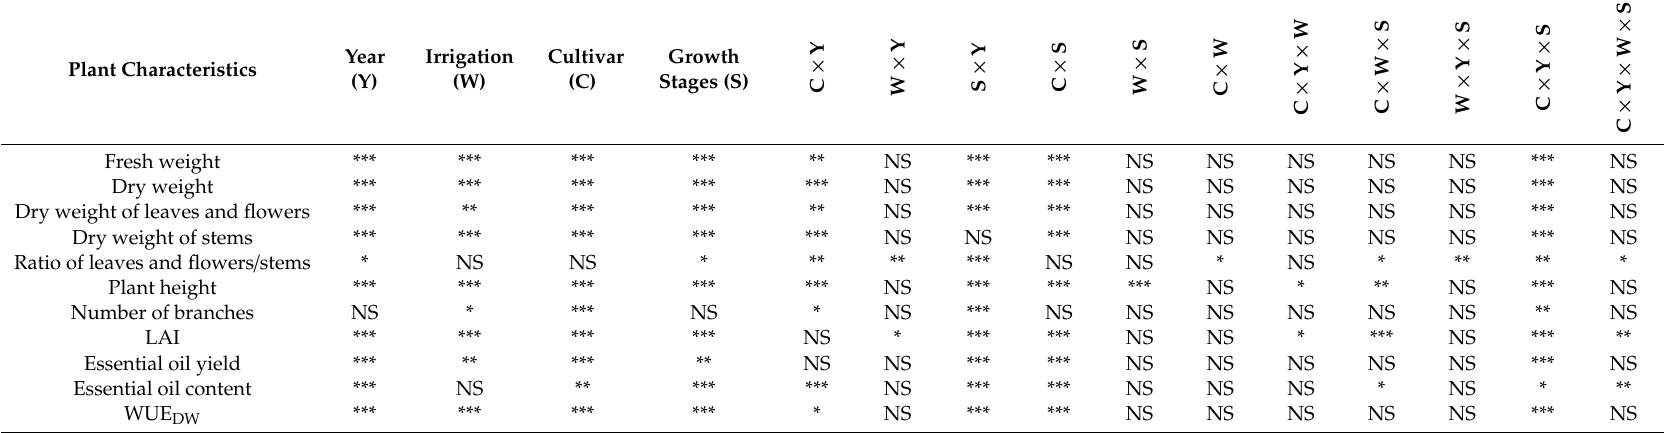
Table 3. Analysis of variance results (significance of the e ff ects) for testing the e ff ects (main and interactions) of Year (Y), Irrigation (W), Cultivar (C), and Growth Stages (S) on the measured plant characteristics. Where LAI is leaf area index, and WUE is water use e ffi ciency.